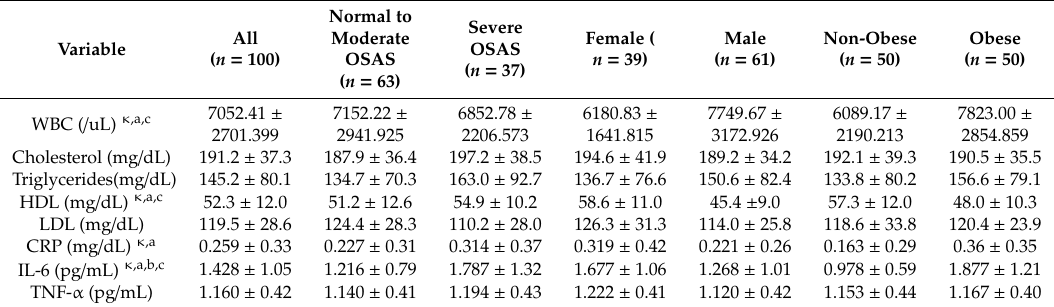
Table 3. Blood measurements of the studied